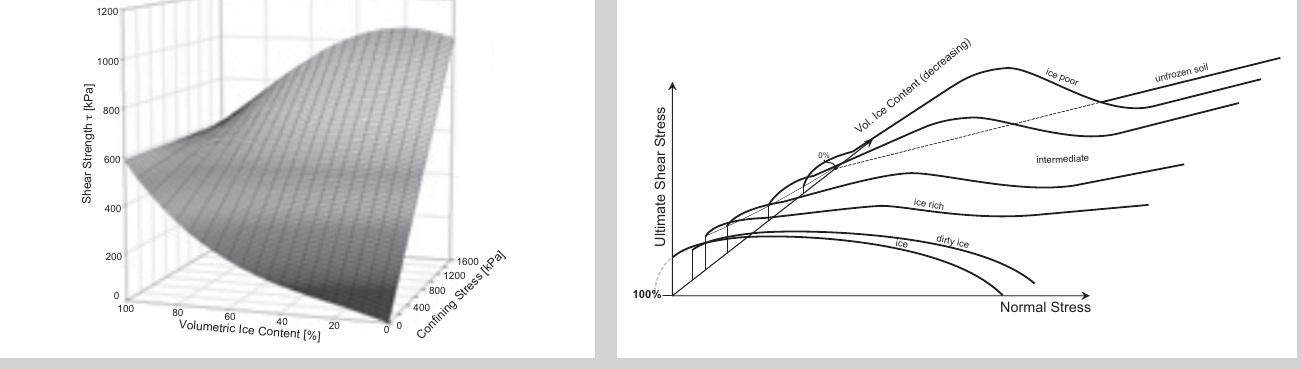
Figure 7: Post-peak shear strength as a function of the volumetric ice content and confine- ment for a sandy gravel at a temperature of about - 2ºC and an axial strain rate of about 1·10 -7. s -1 (after [94]). The data are valid for these particular conditions only. Figure 8: Schematic representation of the failure envelope for frozen soils at a distinct